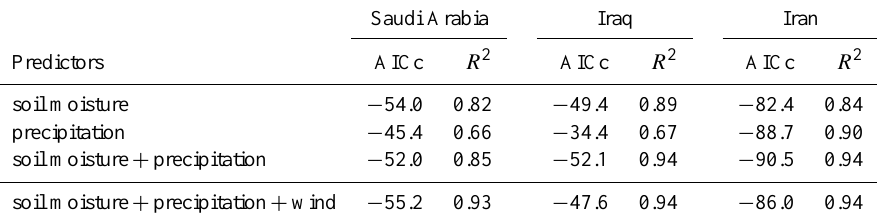
Table 1. Small-sample-size corrected Akaike information criterion (AICc) and R 2 values for linear AOD models using different predictors. For each country, lower AICc values indicate preferable models. For Iran, precipitation is a more relevant predictor than soil moisture, suggesting greater relevance for atmospheric aerosol transport than in Saudi Arabia and Iraq. Only for Saudi Arabia, the model can be improved by including surface wind as predictor (last row). Corresponding scatter plots are shown in Fig. S30 in the Supplement. Saudi